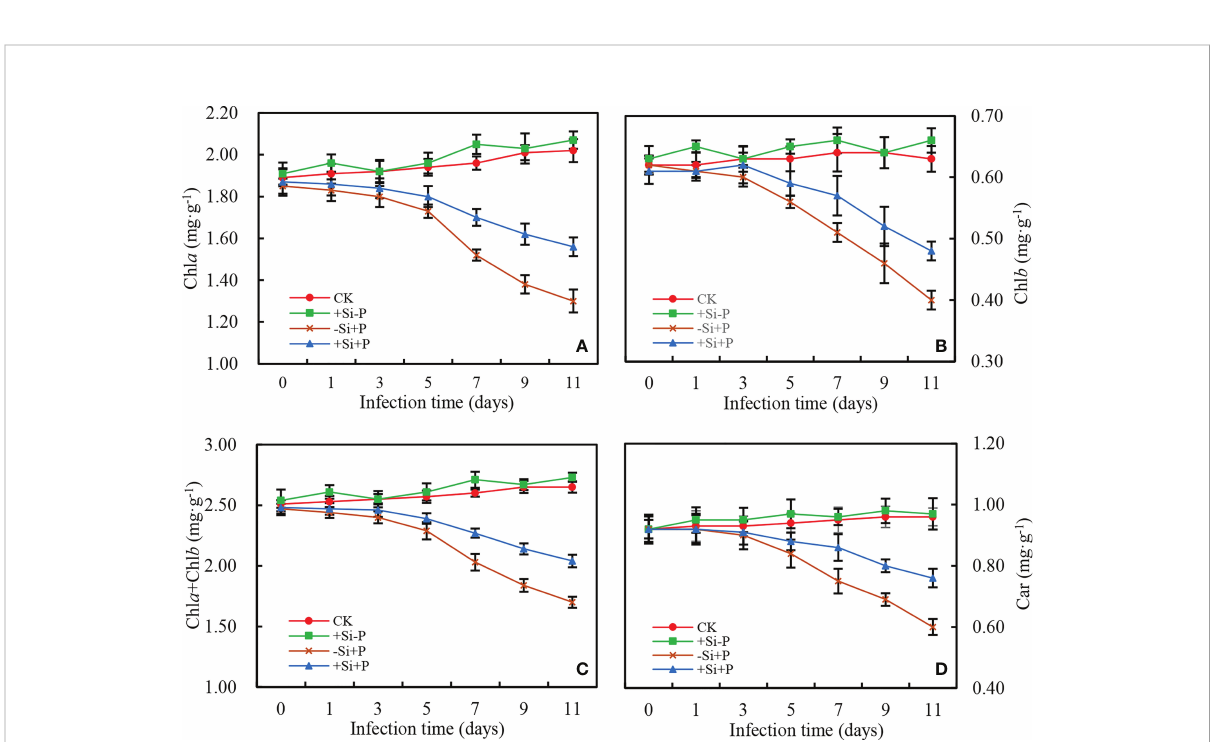
FIGURE 5 Effects of Si application and Pga inoculation on photosynthetic pigment content of oat leaves. (A) , chlorophyll a (Chla); (B) , chlorophyll b (Chlb); (C) , chlorophyll a+b (Chla+Chlb); (D) , total carotenoids (Car). CK, no Si application and no Pga inoculation; +Si-P, 1.5 mmol·L – 1 Si application and no Pga inoculation; -Si+P, no Si application and Pga inoculation; +Si+P, 1.5 mmol·L – 1 Si application and Pga